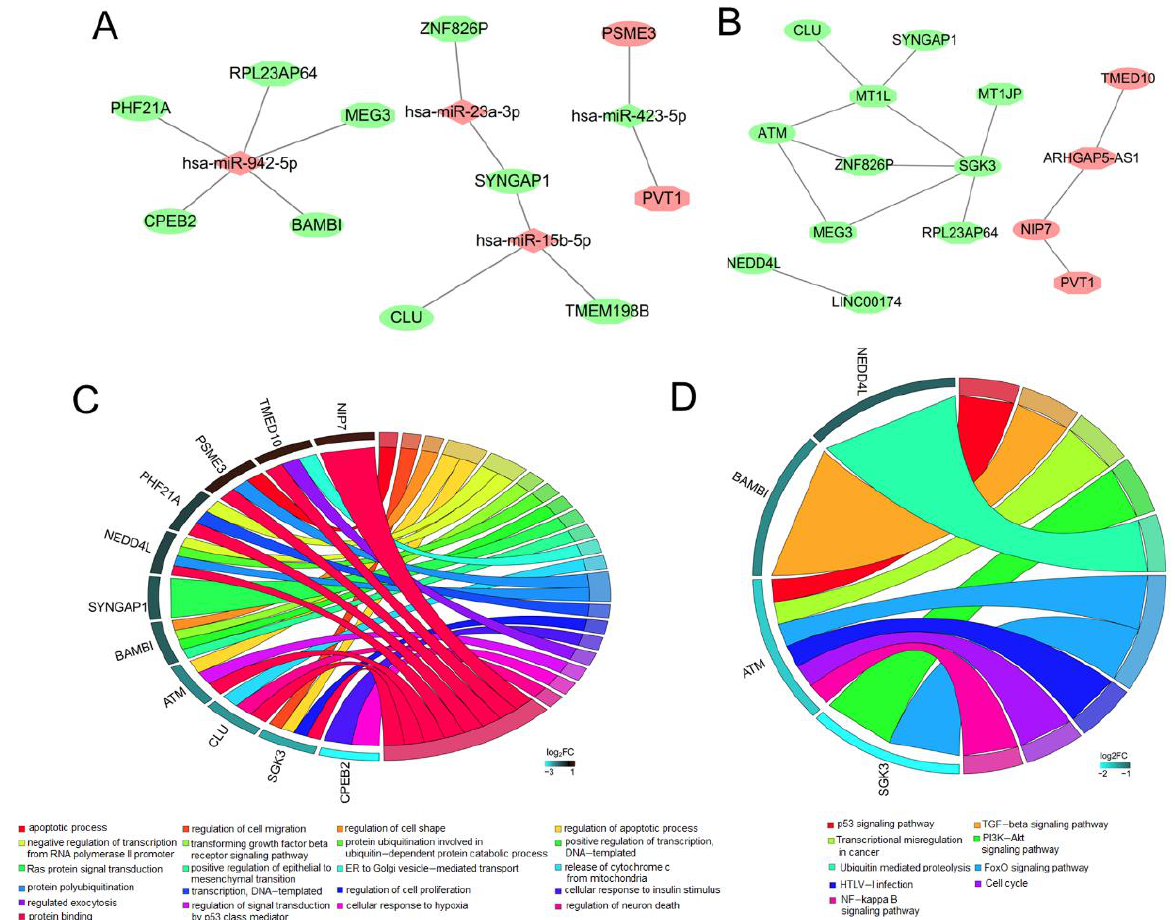
Figure 7. Functions of hub lncRNAs and pseudogenes. ( A ) ceRNA regulatory networks for hub lncRNAs and pseudogenes; ( B ) co-expression regulatory networks for hub lncRNAs and pseudogenes; ( C ) Gene ontology for target mRNAs of hub lncRNAs and pseudogenes; ( D ) KEGG pathway enrichment analysis for target mRNAs of hub lncRNAs and pseudogenes. ceRNA, competing endogenous RNA. Hexagon indicates lncRNAs and pseudogenes; rhombus indicates miRNAs; ellipse indicates mRNAs; red, upregulation; green, downregulation.